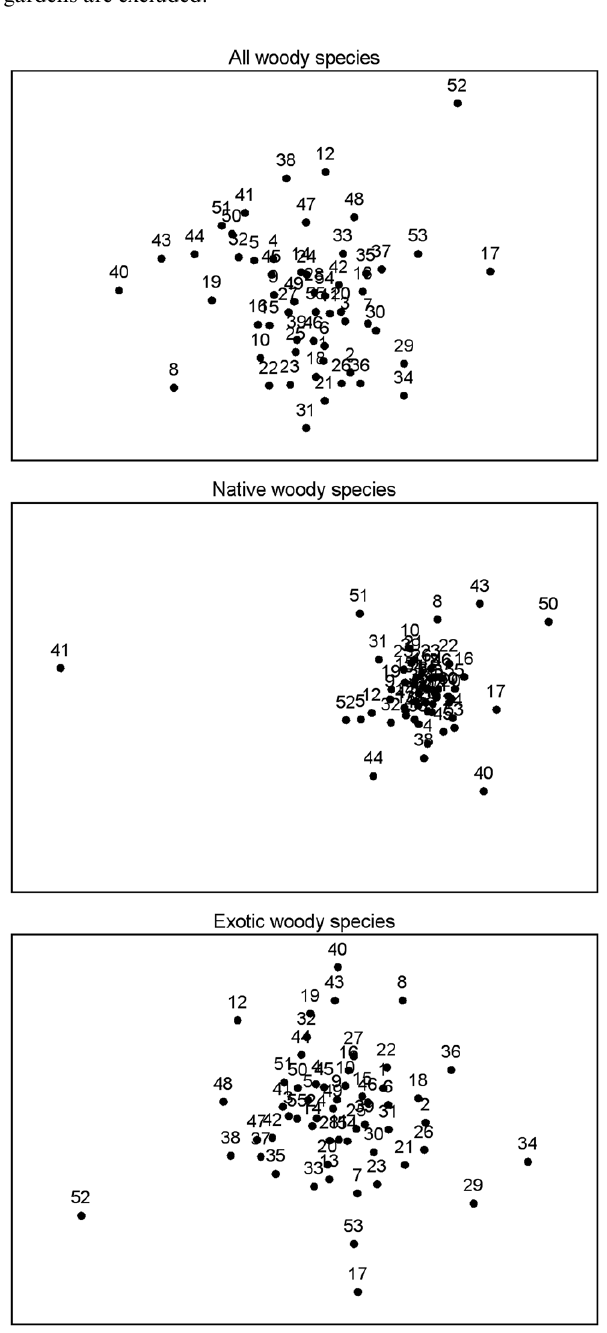
Fig. 4 . Multidimensional scaling (MDS) ordination on woody plant community structure: all woody plants (stress = 0.22), exotic woody plants (stress = 24), and native woody plants (stress = 0.16) in 55 gardens in Dunedin. Garden numbers are indicated on the plot. Species occurring < 5 times across all gardens are